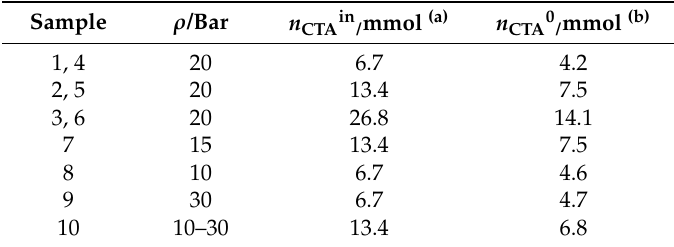
Table 1. Reaction conditions for polymerizations carried out at 75 ◦ C: (a) amount of CTA added to the reactor and (b) amount of CTA available for chain